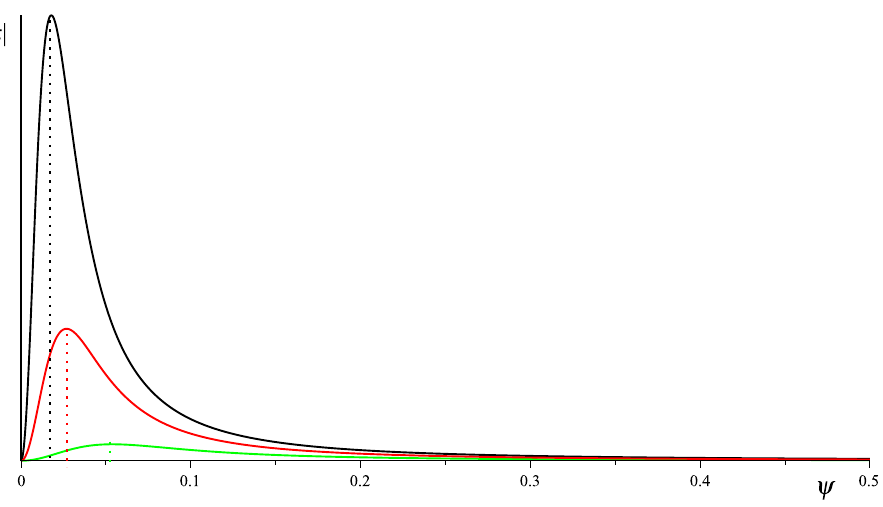
Figure 2 . The angular dependence of the radiation amplitude in four dimensions for di(cid:11)erent values of Lorentz factor: (cid:13) = 15 (green), (cid:13) = 30 (red) and (cid:13) = 45 (black) (units { 2 (cid:22) E ! (cid:0) 2 = 1 are